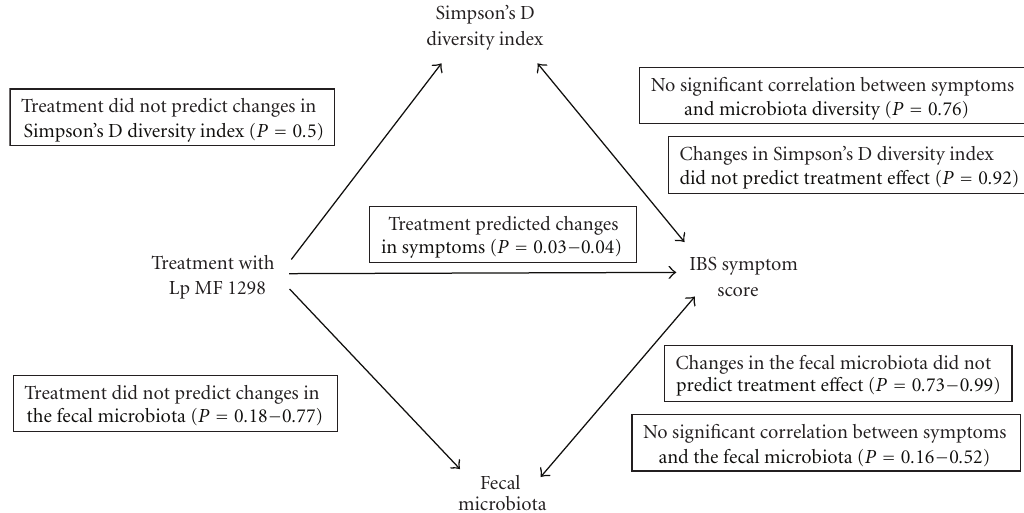
Figure 1: A schematic presentation of all results in the trial showing the associations between treatment with probiotics (Lp MF 1298), the fecal microbiota (composition and diversity), and